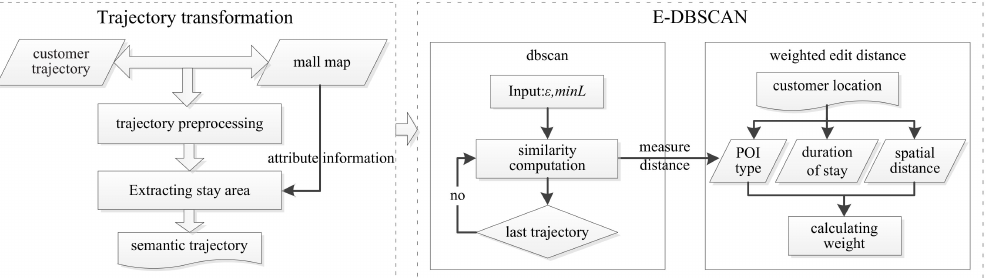
Figure 1. A procedure for trajectories clustering by E-DBSCAN.